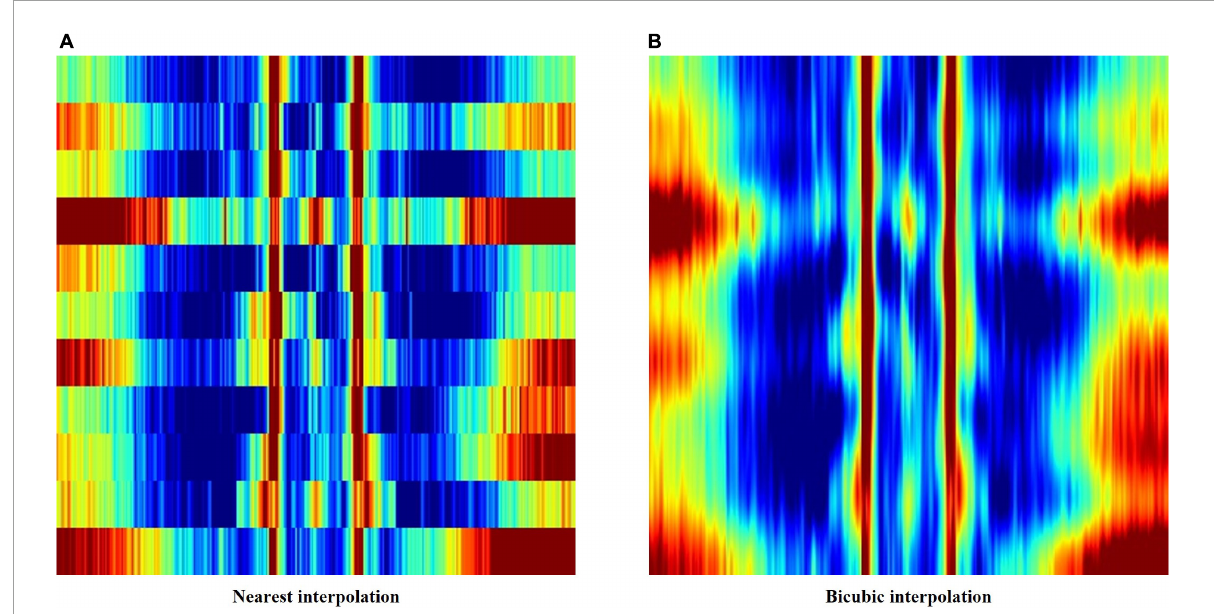
FIGURE3 (A) Feature image created using nearest interpolation. (B) Feature image created using bicubic interpolation from the same electroencephalography (EEG) data.